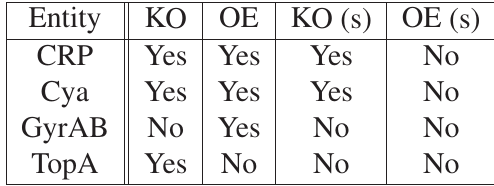
Figure 7: Results of knocking out (KO) and overexpressing (OE) entities (where (s) denotes the presence of carbon